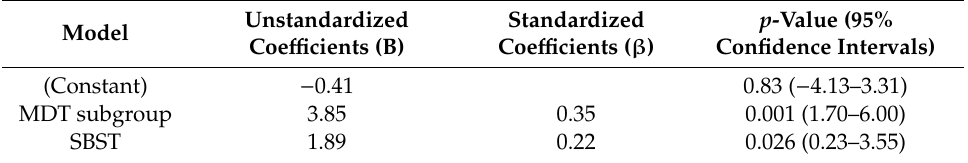
Table 3. Results of multiple regression modeling for the number of sessions until the discharge from the mechanical diagnosis and therapy